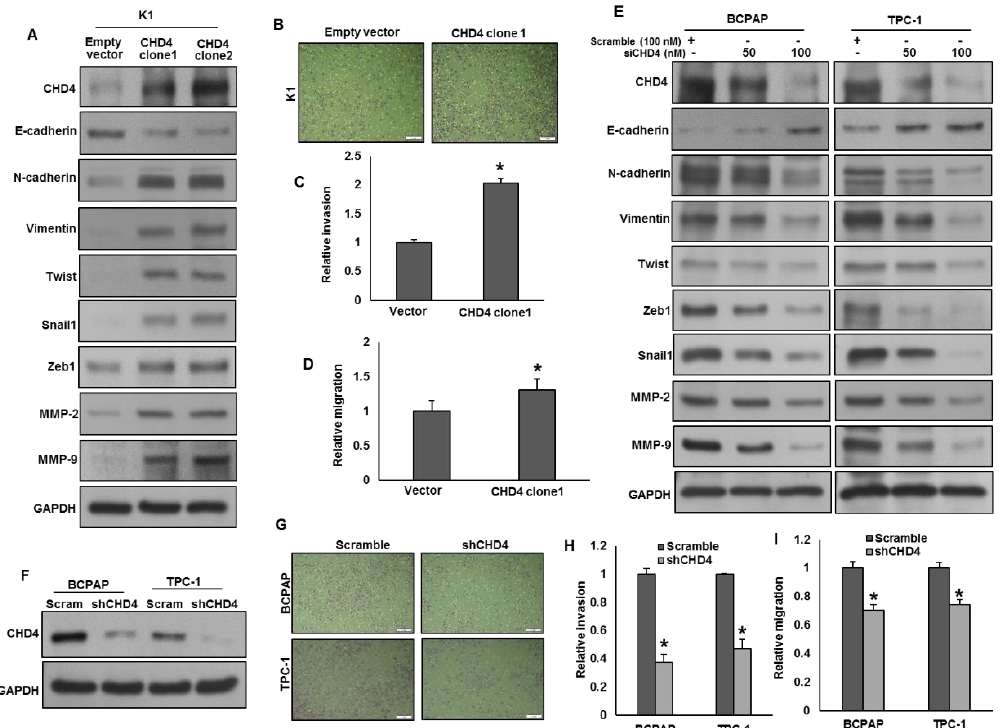
Figure 4. CHD4 activates epithelial-to-mesenchymal transition in PTC cells. ( A ) Forced expression of CHD4 activates EMT. K1 cells were transfected with either empty vector or CHD4 cDNA. After cell lysis, equal amounts of proteins were separated by SDS-PAGE, transferred to immobilon membrane, and immuno-blotted with antibodies against CHD4, E-cadherin, N-cadherin, Vimentin, Twist, Snail1, Zeb1, MMP-2, MMP-9 and GAPDH as indicated. ( B , C ) Forced expression of CHD4 increases invasion. K1 cells were transfected with either empty vector or CHD4 cDNA. Cells were seeded into the upper compartment of invasion chambers. The bottom chambers were filled with RPMI media. After 24 h incubation, invaded cells were fixed, stained and quantified. (Scale bars, 1 mm). ( D ) Forced expression of CHD4 increases migration. K1 cells were transfected with either empty vector or CHD4 cDNA. Cells were seeded into the upper compartment of migration chambers. The bottom chambers were filled with RPMI media. After 24 h incubation, migrated cells were fixed, stained and quantified. ( E ) Silencing of CHD4 down-regulates the expression of EMT markers in PTC cells. PTC cells were transfected with scrambled siRNA and CHD4 siRNA (50 and 100 nM). After 48 h, cells were lysed and proteins were immunoblotted with antibodies against CHD4, E-cadherin, N-cadherin, Vimentin, Twist, Snail1, Zeb1, MMP-2, MMP-9 and GAPDH. ( F ) Knockdown of CHD4 in expressing cells. ( G , H ) Knockdown of CHD4 decreases invasive ability of PTC cells. PTC cells were transfected with CHD4 shRNA and cells were subjected to invasion assay. (Scale bars, 1 mm). ( I ) Knockdown of CHD4 decreases migratory ability of PTC cells. PTC cells were transfected with CHD4 shRNA and cells were subjected to migration assay. Data presented in the bar graphs are the mean ± SD of two independent experiments. * Indicates a statistically significant difference compared to control with p < 0.05.